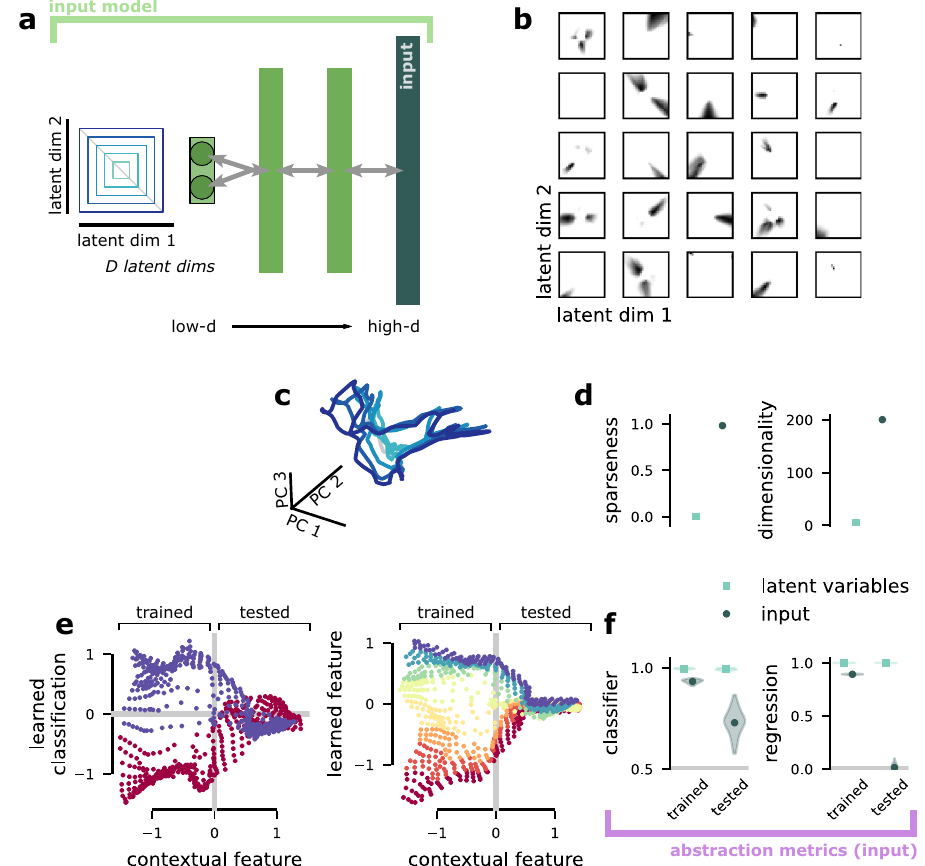
Fig. 2 | The input model. a Schematic of the input model. Here, schematized for D =2latentvariables.Thequantitativeresultsarefor D =5. b The2Dresponse fi elds of 25 random units from the high-d input layer of the standard input. c The same concentricsquarestructureshowntorepresentthelatentvariablesin a afterbeing transformed by the standard input. d (left) The per-unit sparseness (averaged across units) for the latent variables ( S =0, by de fi nition) and standard input ( S =0.97). (right) The embedding dimensionality, as measured by participation ratio, of the latent variables (5, by de fi nition) and the standard input (~190). e Visualization of the level of abstraction present in the high-d input layer of the standard input, as measured by the classi fi er generalization metric (left) and regressiongeneralizationmetric(right).Inbothcases,they-axisshowsthedistance from the learned classi fi cationhyperplane (right: regression output) fora classi fi er